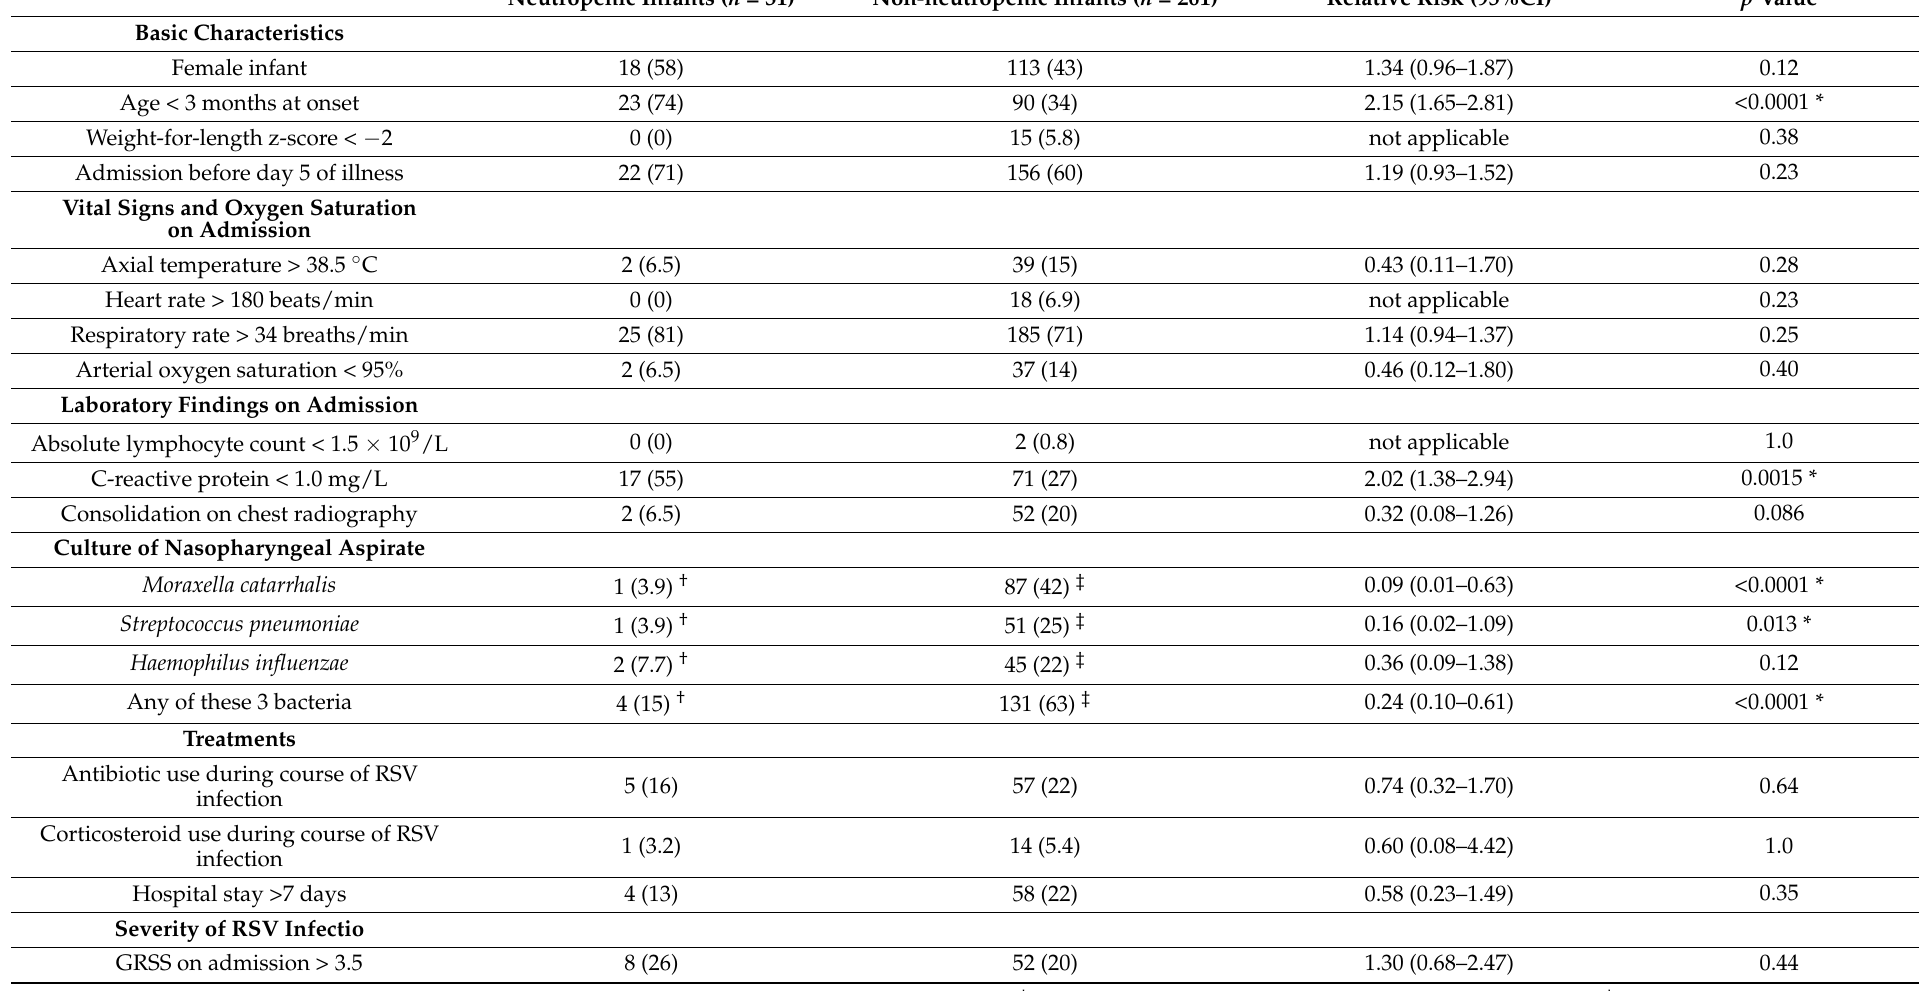
Table 1. Comparison of clinical manifestations between RSV-infected infants with and without neutropenia <1.0 × 10 9